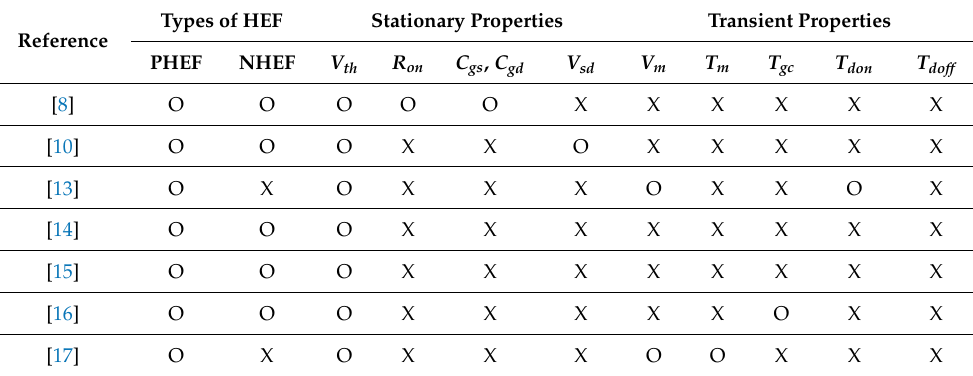
Table 1. Summary of previous research about characteristics of SIC MOSFETs under gate oxide